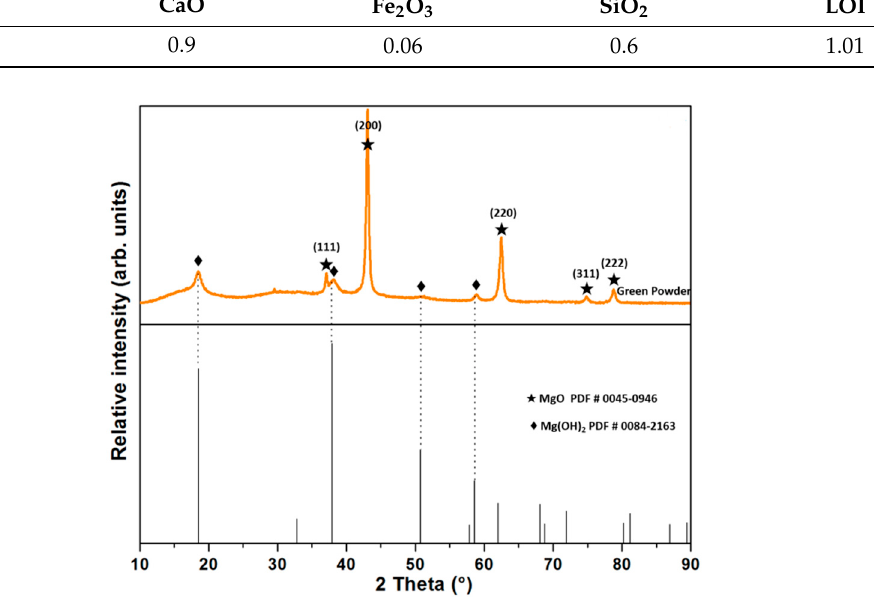
Figure 1. X-ray di ff raction (XRD) patterns of MgO as raw material (green powder). Table 1. Chemical composition (wt.%) of magnesia.